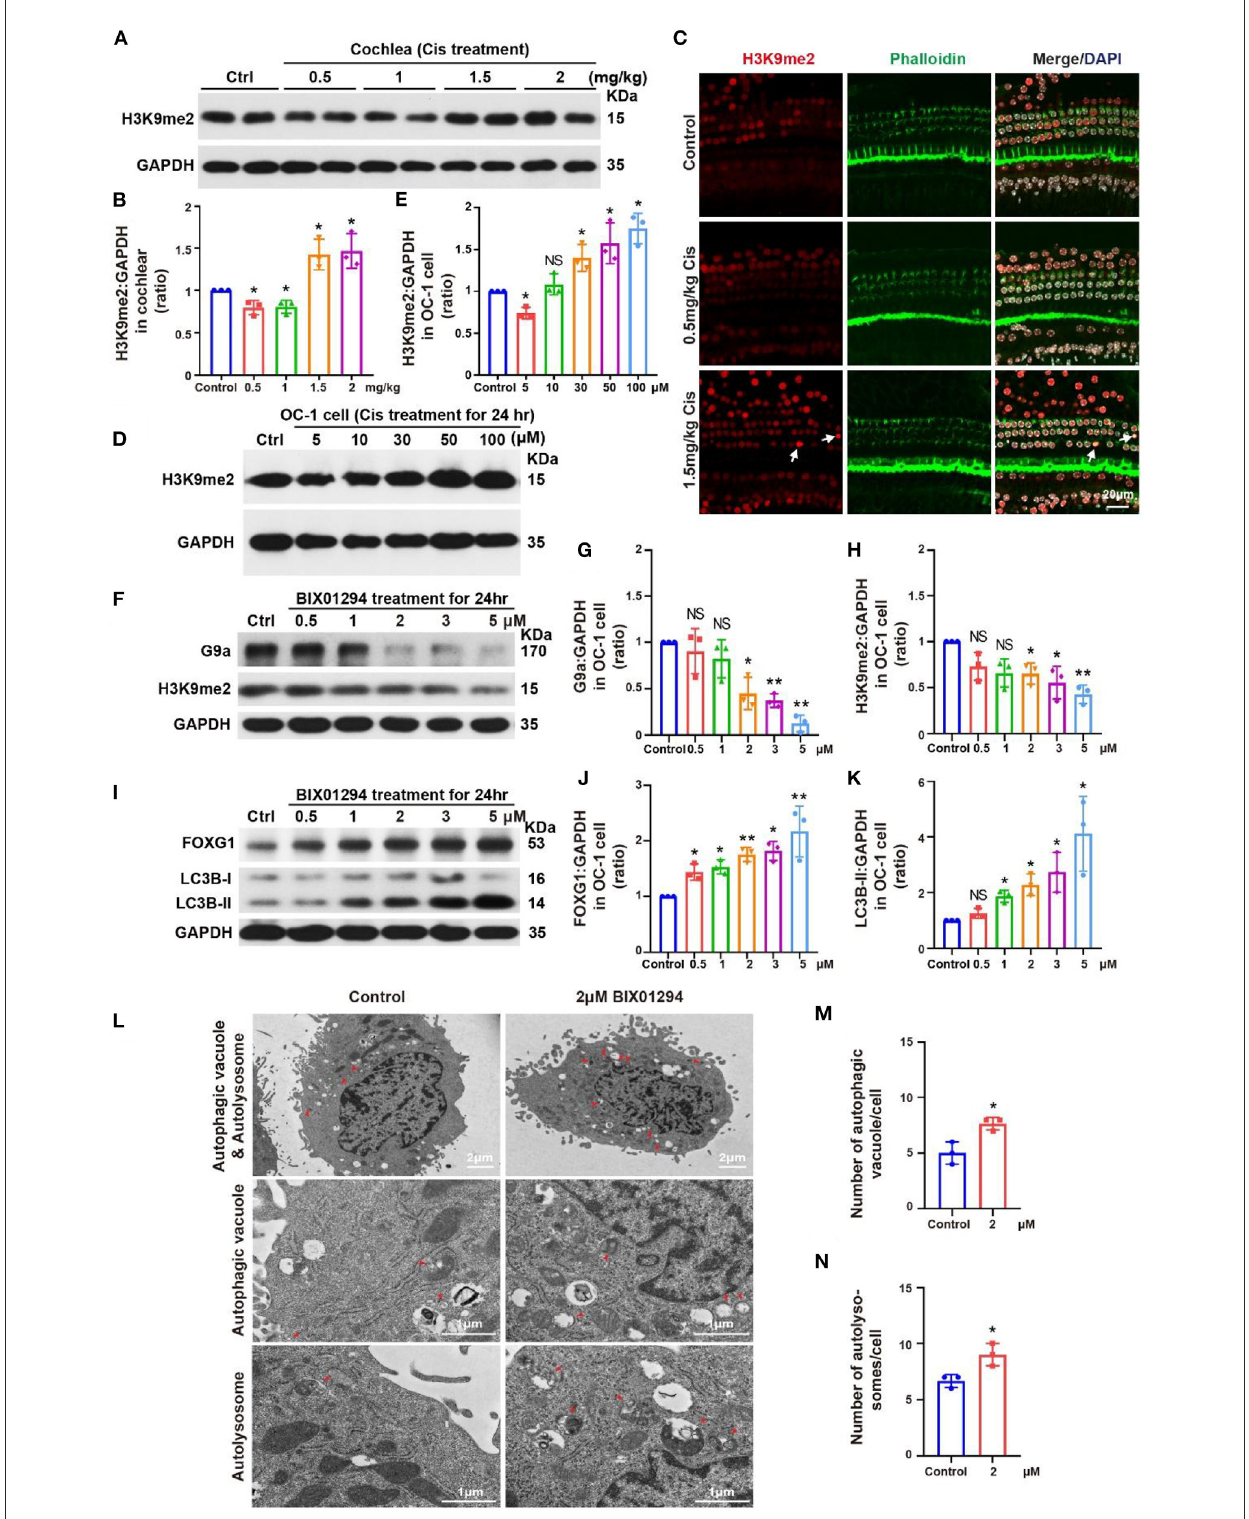
FIGURE5 Changes in H3K9me2 levels in the cochlea and OC-1 cells after treatment with different cisplatin concentrations. (A) Western blotting of changes in H3K9me2 levels in the cochlea after treatment with different cisplatin concentrations. (B) Quantification of the western blotting in (A) . (C) Immunofluorescence staining for H3K9me2, phalloidin, and DAPI in the cochlea after cisplatin treatment. (D) Western blotting of changes in H3K9me2 levels after treatment with different cisplatin concentrations for 24h. (E) Quantification of the western blotting in (D) . (F) Western blotting of changes in H3K9me2 levels with different BIX01294 concentrations for 24h. (G, H) Quantification of the western blotting in (F) . (I) Western blotting of changes in FOXG1 and LC3B levels after treatment with different BIX01294 concentrations for 24h. (J, K) Quantification of the western blotting in (I) . (L) TEM of the changes in autophagic vacuoles and autolysosomes after treatment with 2 µ M BIX01294 for 24h. (M) Quantification of the autophagic vacuoles changes in (L) . (N) Quantification of the autolysosomes changes in (L) . * p < 0.05, ** p <